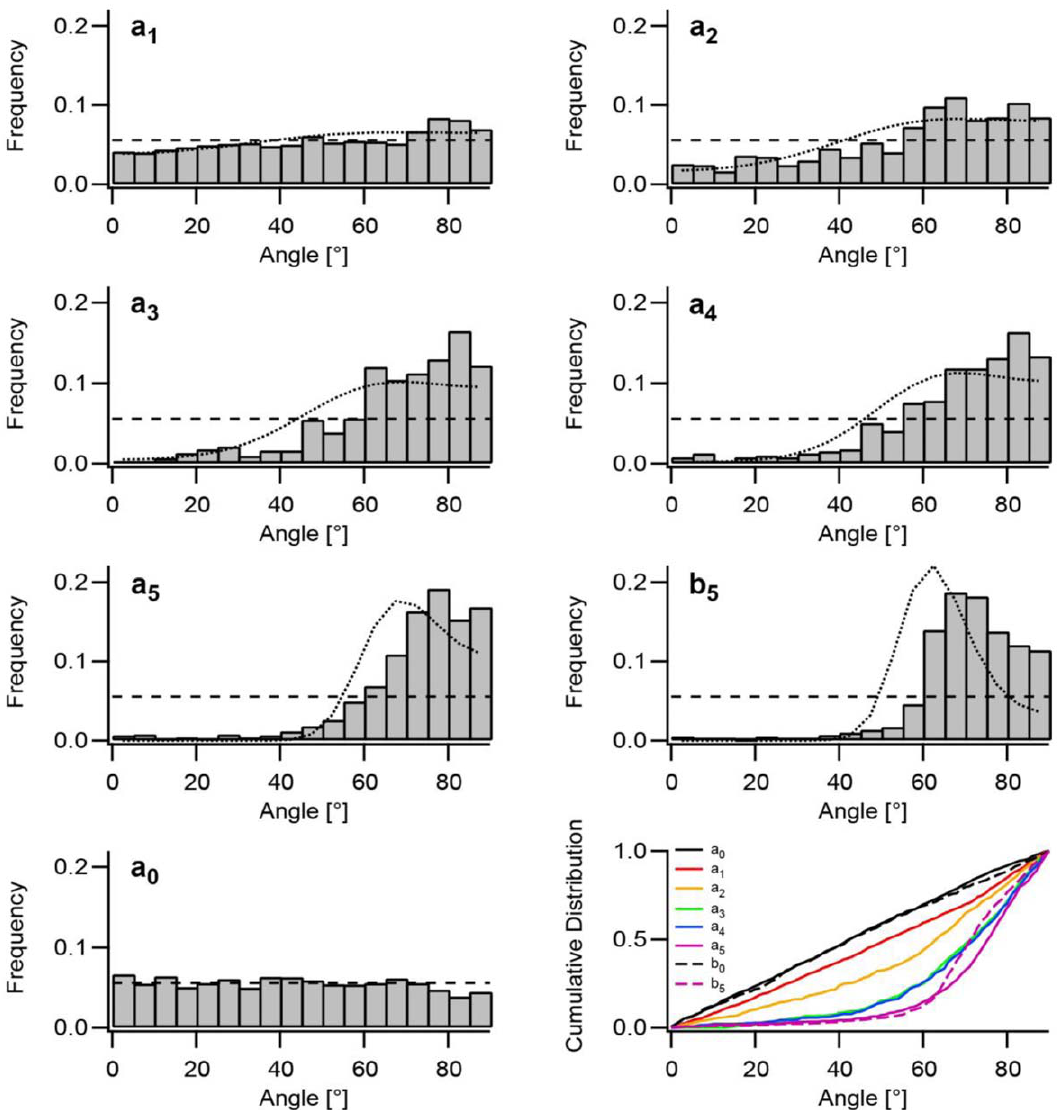
Figure 4. Orientation of stress fibers in response to uniaxial cyclic stretch. The predominant cytoskeletal orientations were determined for cells stretched for 16 hours at amplitudes a 1 (4.9%, 1493 cells), a 2 (8.4%, 662 cells), a 3 (11.8%, 625 cells), a 4 (14.0%, 397 cells), and a 5 (32%, 772 cells) in box-shaped chambers ( k =0.15) and at amplitude b 5 (31.7%, 588 cells) on ribbon-like substrates ( k =0.29). Control measurements in both types of chambers (a 0 (0%, 1417 cells), b 0 (0%, 640 cells, b 0 only indicated as cumulative plot)) showed random distributions. Distributions are given as histograms and cumulative distributions (bottom right). The dashed line in each histogram indicates a random distribution. The dotted lines